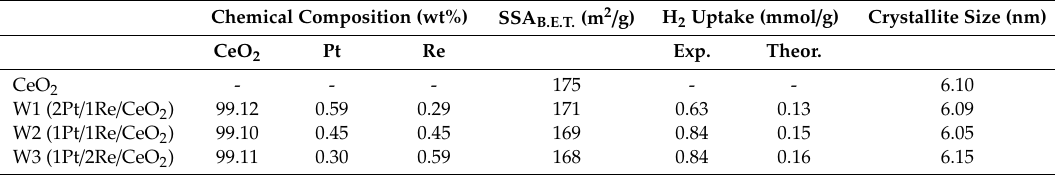
Table 1. Powder catalysts